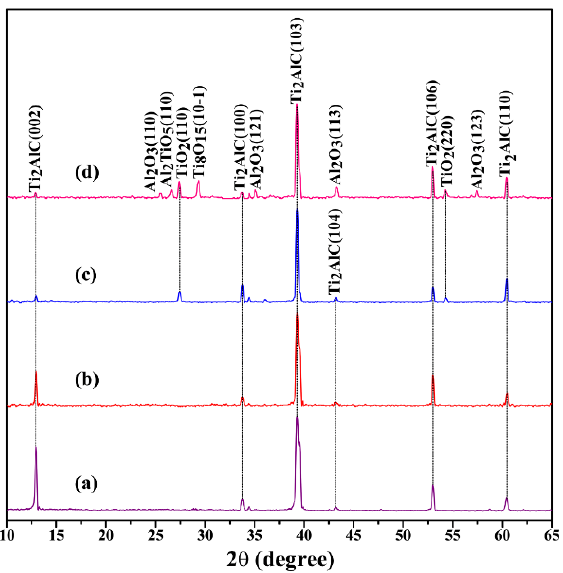
Figure 1. X-ray diffraction (XRD) patterns of Ti 2 AlC samples quenched in air at different temperature: ( a ) 25 °C, ( b ) 480 °C, ( c ) 920 °C, and ( d ) 1150 °C. Table 2. Phase compositions of sample surface of Ti 2 AlC ceramic quenched in air at different temperatures. Temperature Phase